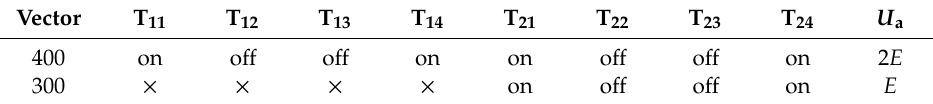
Table 1. Comparison of switching state in phase A under faulty